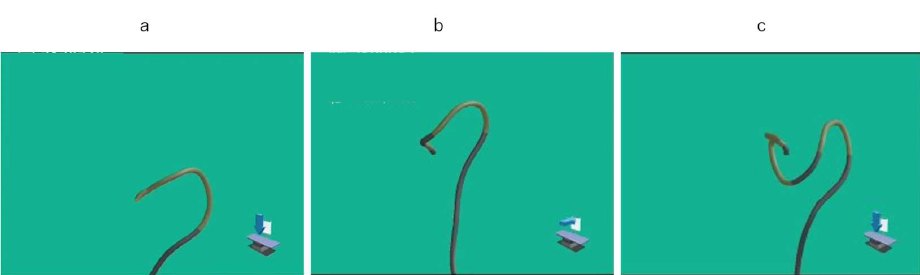
Figure 3. Endoscopic position detection unit (UPD) graphic image of patterns for passing through the hepatic flexure: ( a ) suction of air and right rotation procedure; ( b ) operation with positional change; ( c ) operation with push procedure.